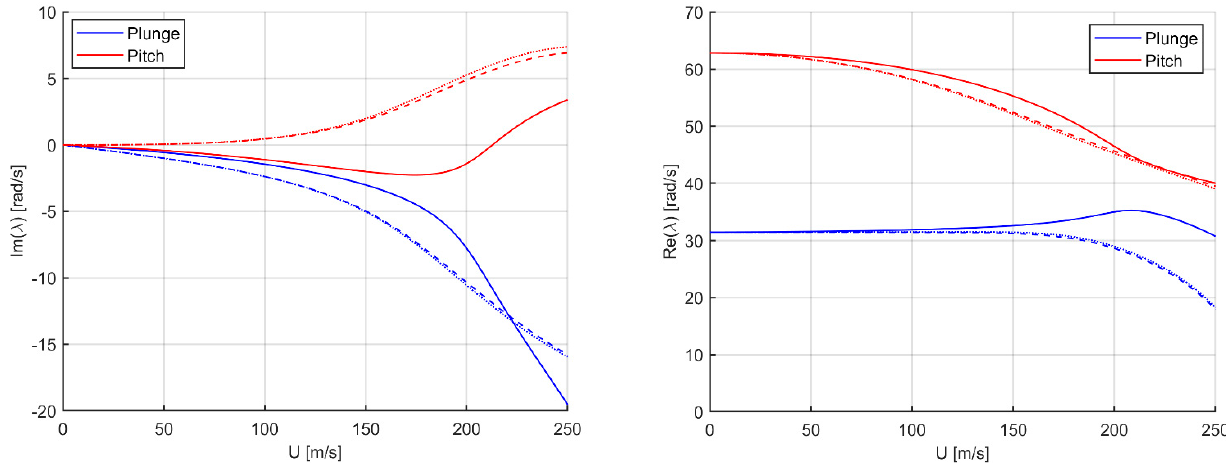
dotted lines for US, SU and SQU aerodynamic models, respectively.